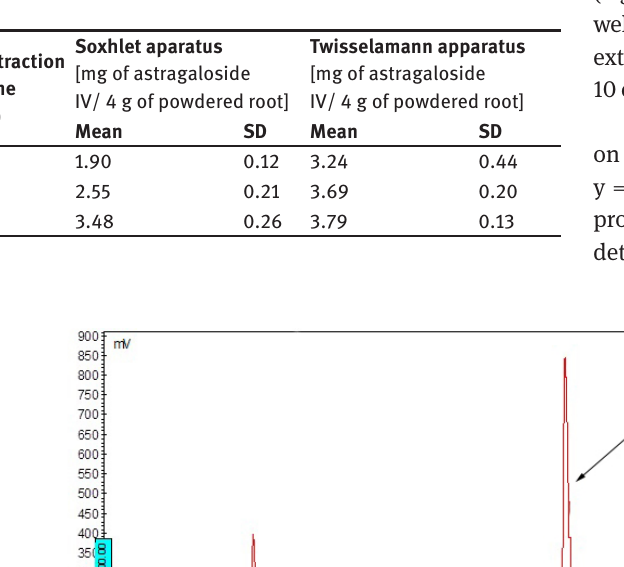
Table 1 : An average astragaloside IV content in the extracts obtained in different apparatus and extraction duration.